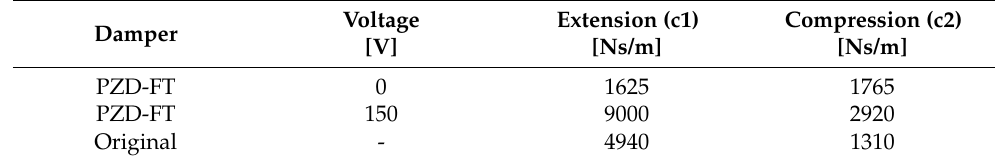
Figure 9. The course of the change of the delay of the damping force and the course of the signal feeding the piezoelectric stack 0–150 V. Table 1. Dissipation properties of PZD-FT damper.